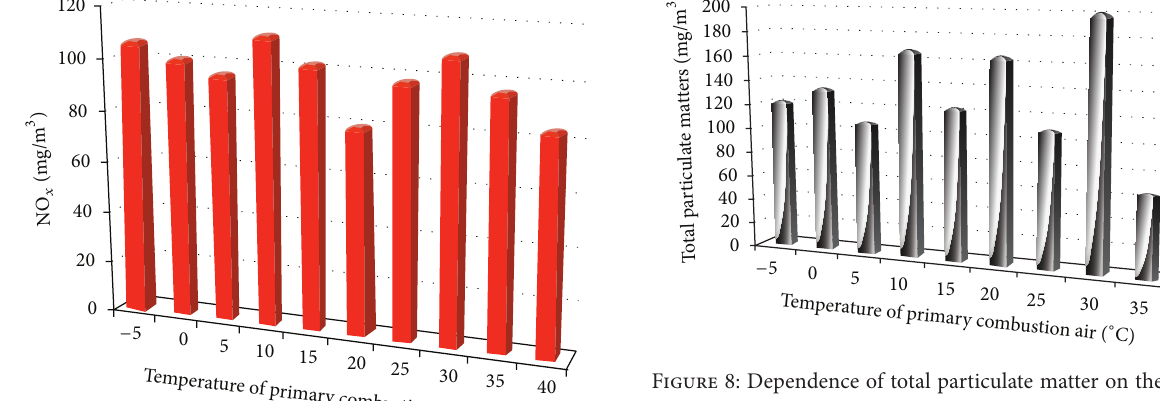
Figure 8: Dependence of total particulate matter on the tempera- ture.